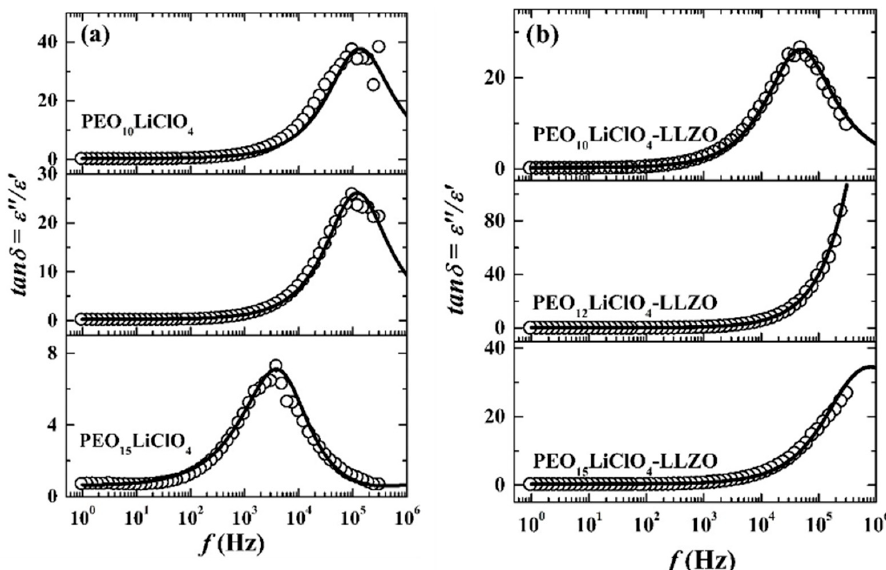
Figure 3. Frequency dependence of ε  and ε  of ( a ) PEO n LiClO 4 and ( b ) PEO n LiClO 4 ‐ LLZO. The open circles and solid lines represent the experimental data and the fitted data.